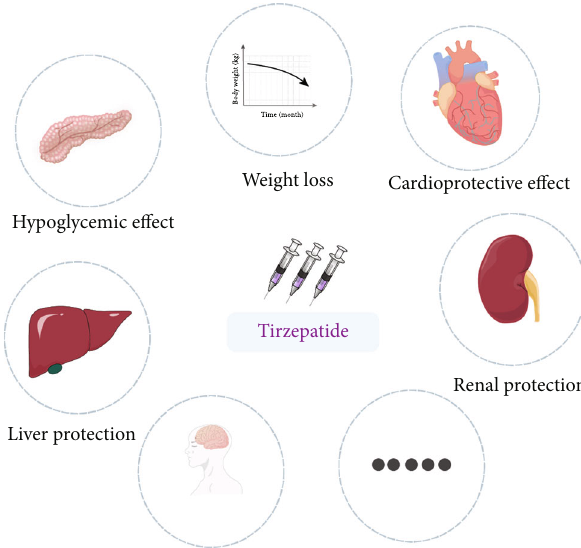
Figure 3: Multiple e ff ects of